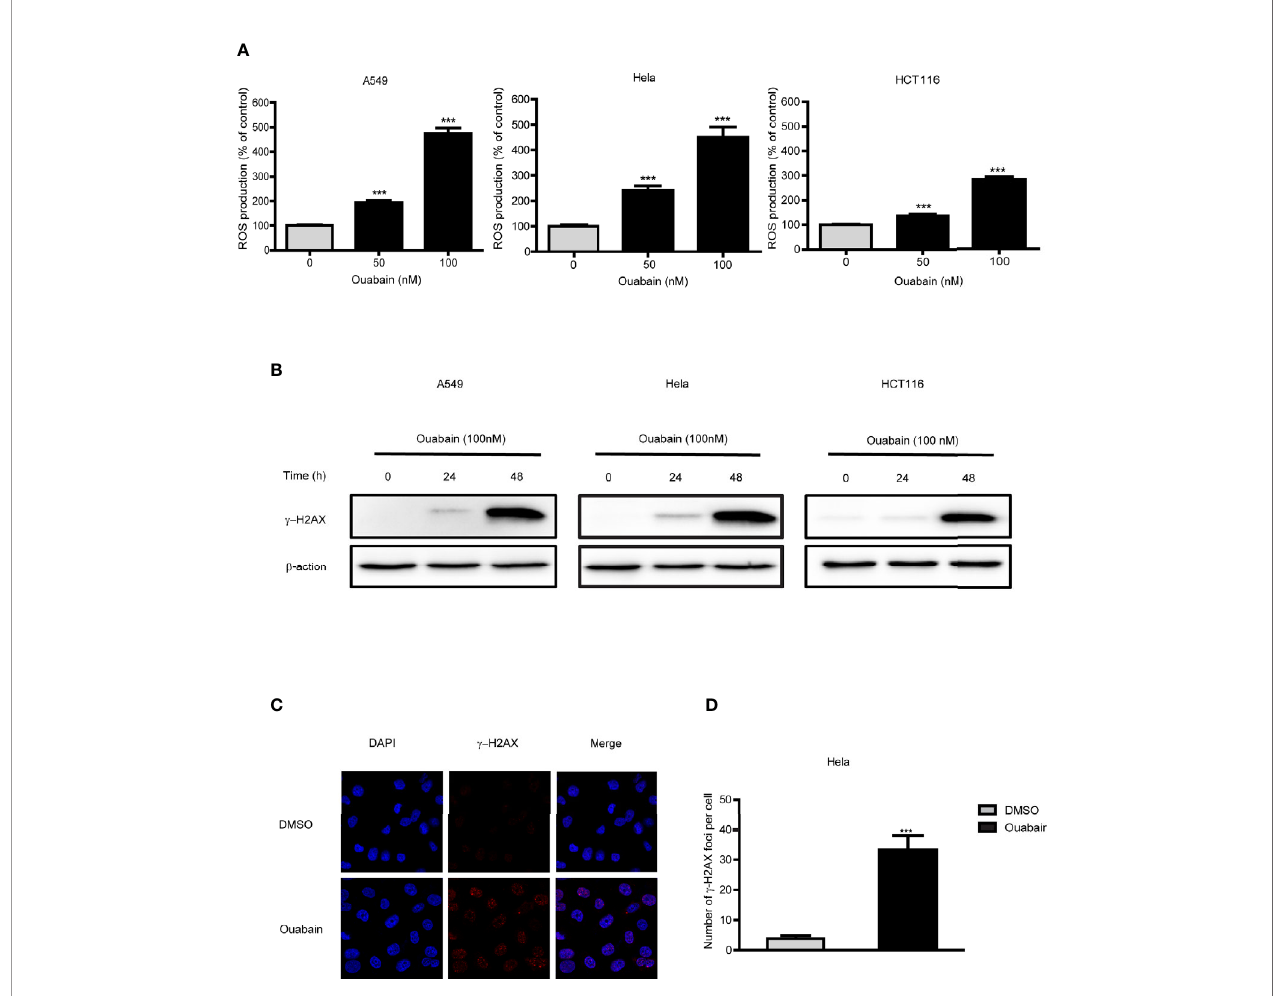
FIGURE 3 | Ouabain increased ROS production and generated DNA double-strand breaks. (A) A549, Hela and HCT116 cells were treated with different concentrations of ouabain for 24 hours, and ROS generation was determined by staining the cells with DCFH-DA. (B) Cells were treated with ouabain (0, 50, 100 nM) for 24 or 48 hours, and expression of g -H2AX were measured by Western blotting. (C) Hela cells were immunostained for g -H2AX foci (red) after exposed to ouabain for 24 hours. (D) The number of g -H2AX foci per cell. *** P < 0.001 versus control group, n =